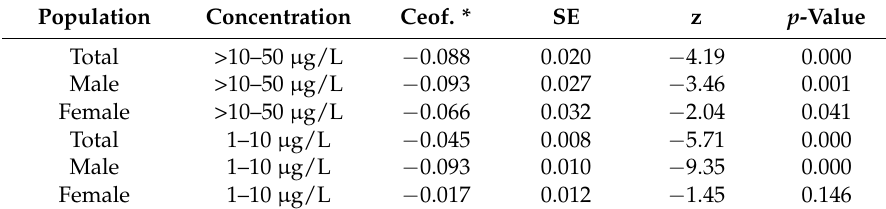
Table 7. Adjusted Poisson Log-Linear models of median arsenic level, stratified at 10 µ g/L and at 50 µ g/L and compared to <1 µ g/L, for counties with ≥ 80% dependency and maximum arsenic ≤ 50 µ